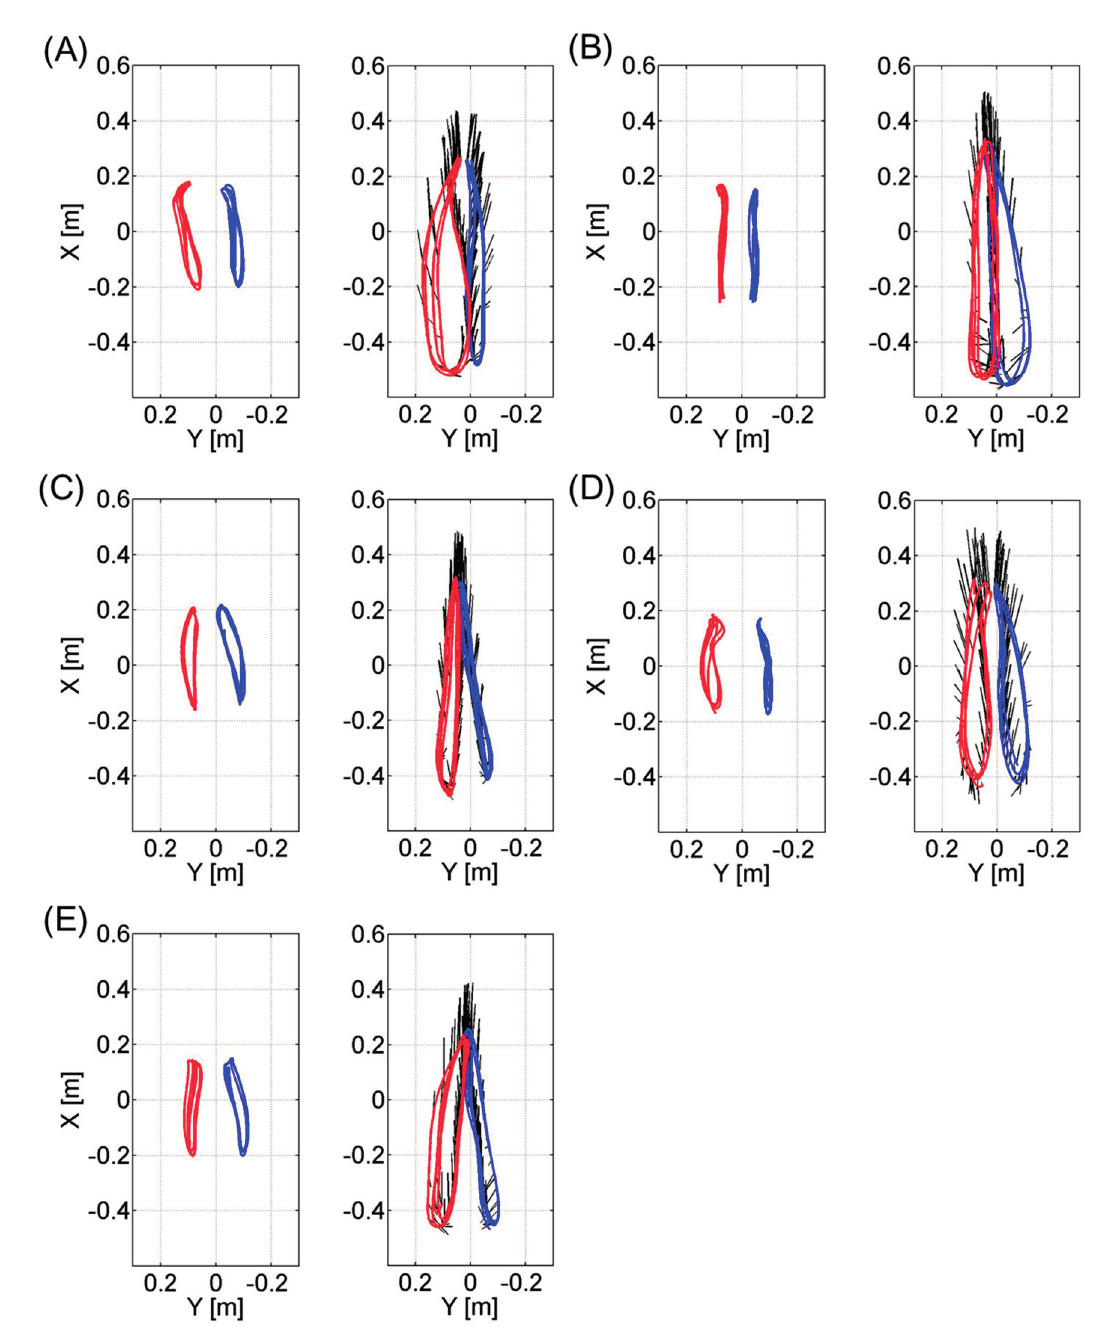
Figure 8. These figures represent the trajectory of the knee ( left figure) and ankle joint ( right figure) center during three gait cycles in the horizontal plane for each volunteer sampled at 33 Hz. The vertical axis represents the X global axis and the horizontal axis represents the Y global axis. The trajectories for the left knee/ankle are shown in red and those for the right knee/ankle are in blue. The black line emanating from the ankle joint trajectories represent the direction of each toe. ( A ) through ( E ) represent the data for each of the five